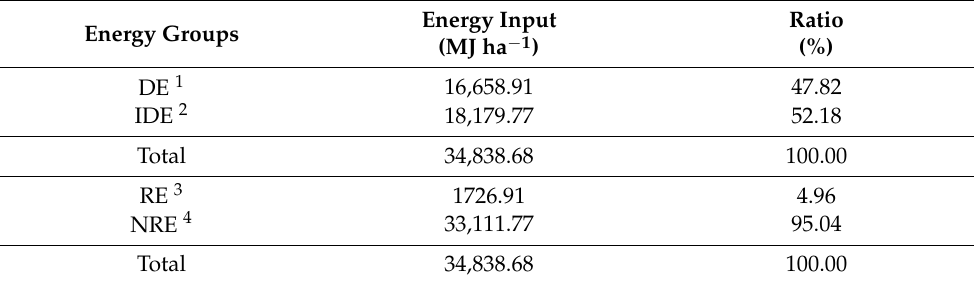
Table 5. Different energy groups of energy inputs in the production of